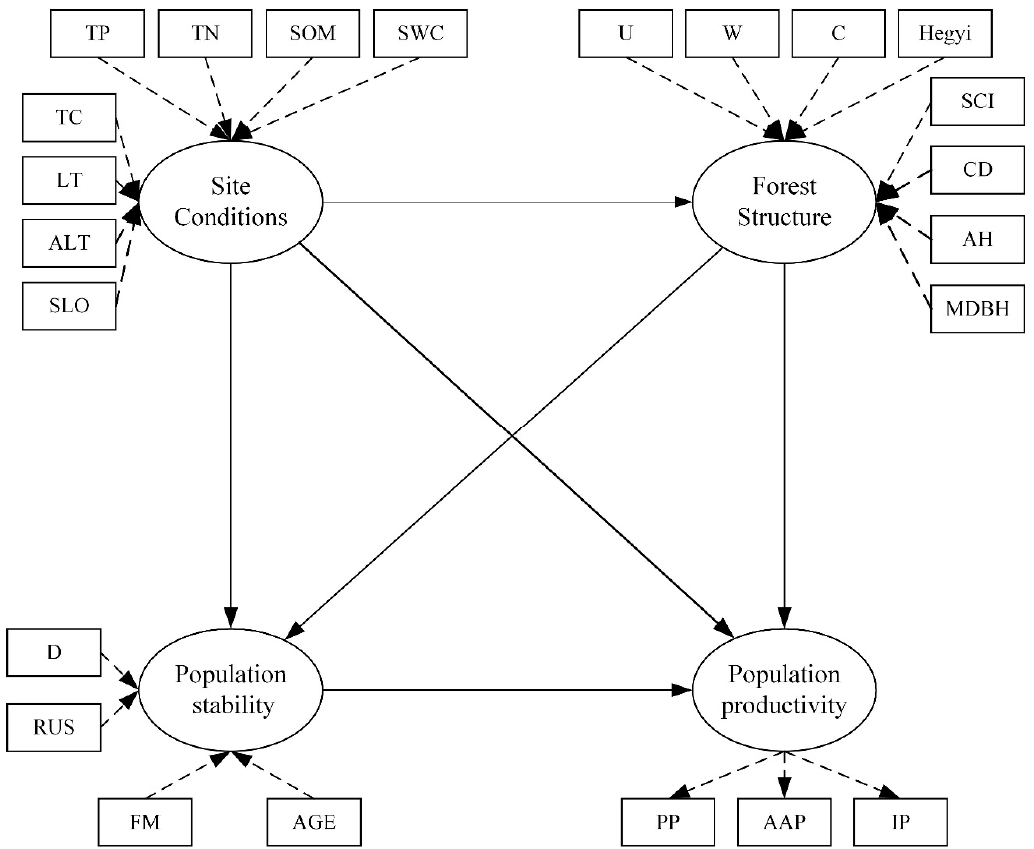
Figure 1. The original partial least squares structural equation model showing the relationship between latent variables. The arrow indicates the effect between latent variables or weight of observed variables to latent variables. The ovals indicate the latent variables; the rectangles indicate the observed variables. LT: Litter thickness; SOM: Soil organic matter; SWC: Soil water content; TC: Soil total carbon; TN: Soil total nitrogen; TP: Soil total phosphorus; ALT: altitude; SLO: Slope; Hegyi: